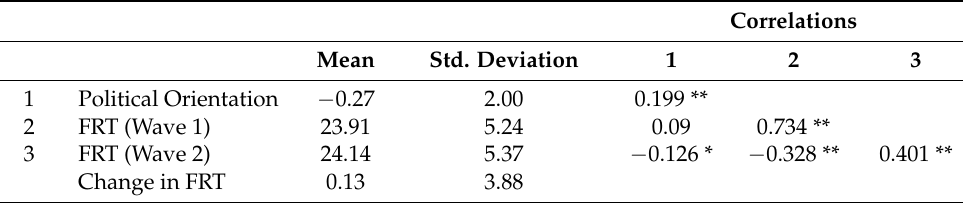
Table 2. Summary statistics and correlations between financial risk tolerance (FRT) and political